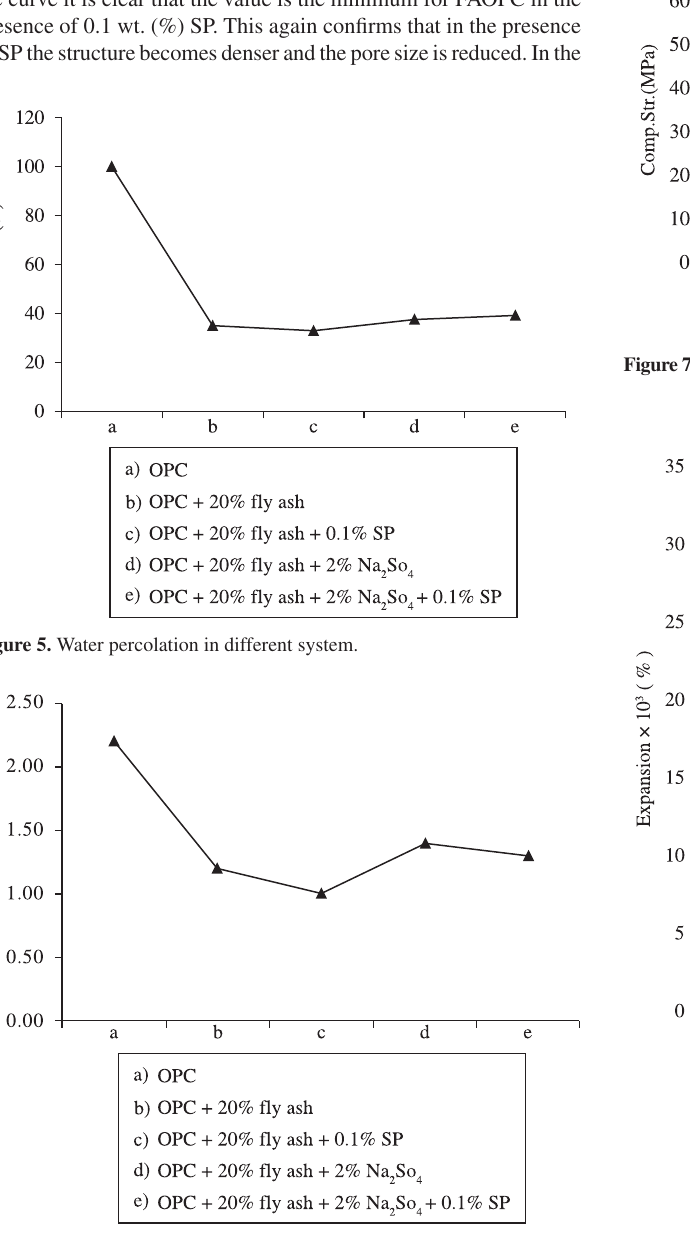
Figure 8. Variation of percent expansion with time in N/60 H